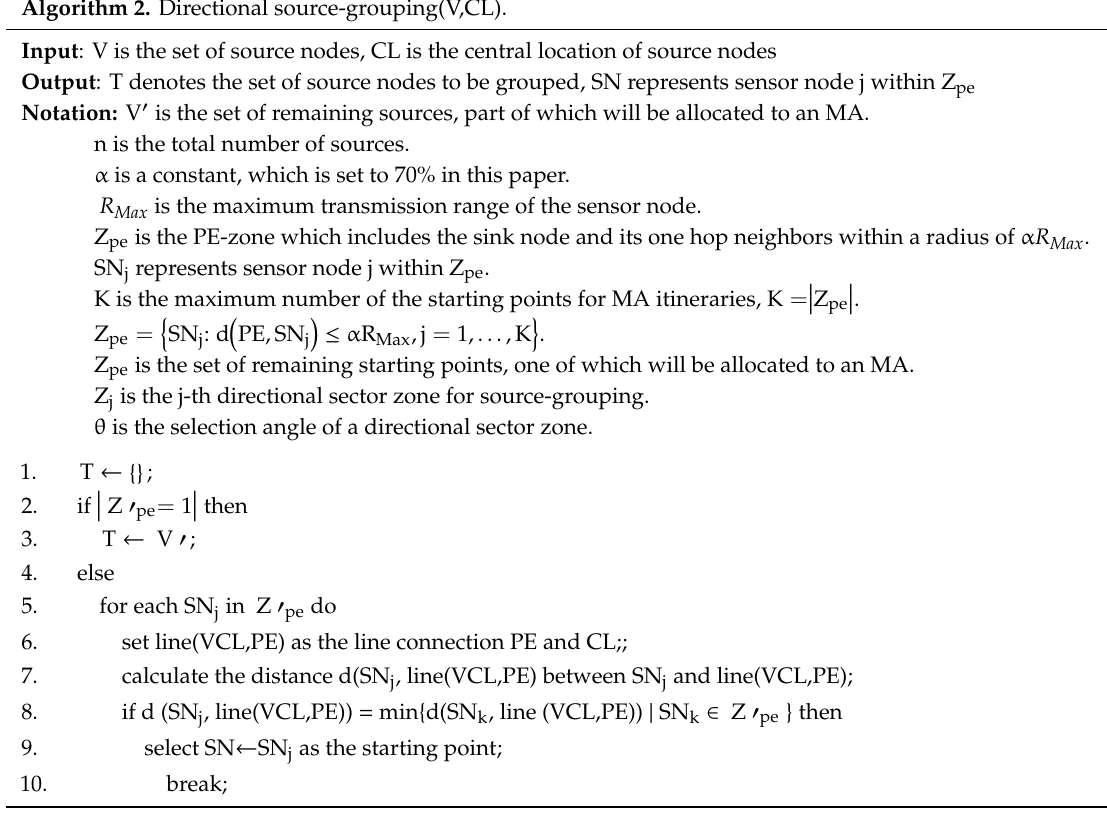
Algorithm 2. Directional